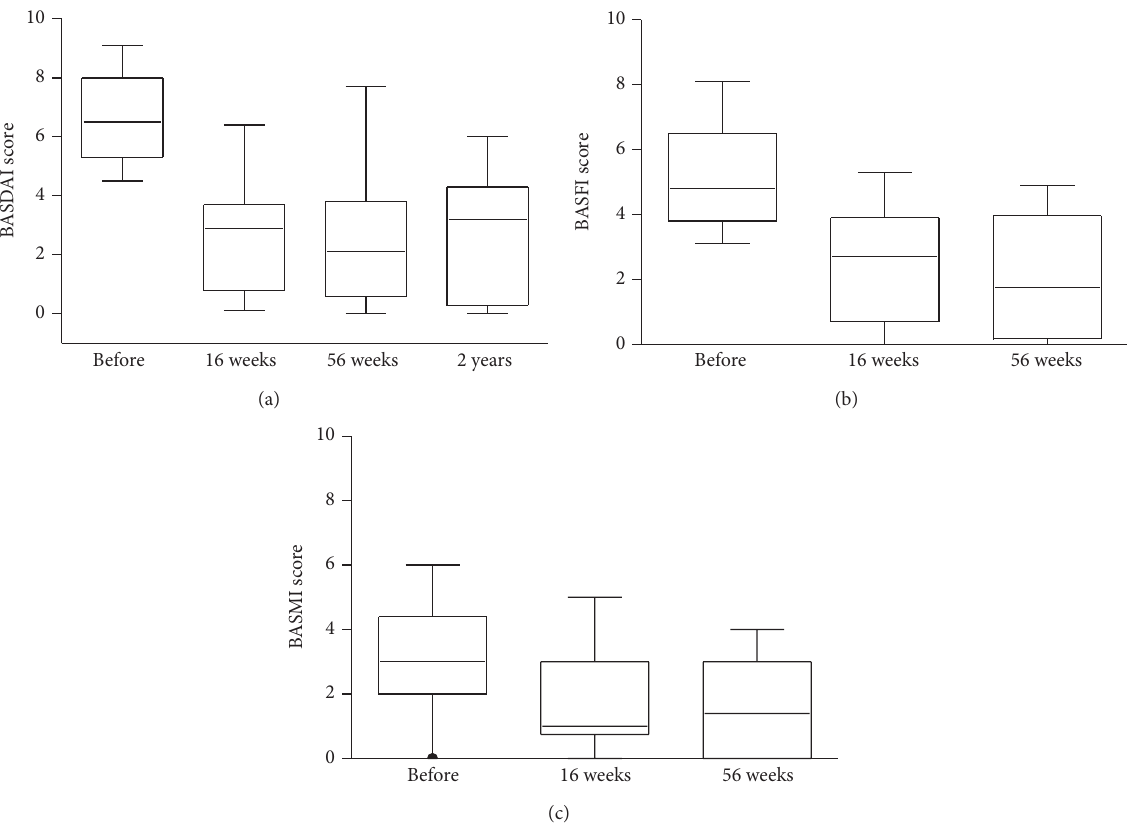
Figure 3: Change in BASDAI, BASFI, and BASMI scores over time. Box plots show the 25th and 75th percentiles. Horizontal solid lines within boxes indicate medians and vertical bars indicate the 5th and 95th